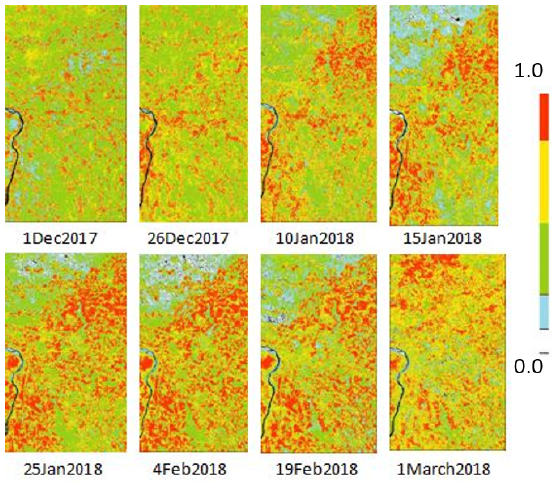
Figure 6. Spatio-Temporal changes of NDVI in study area.